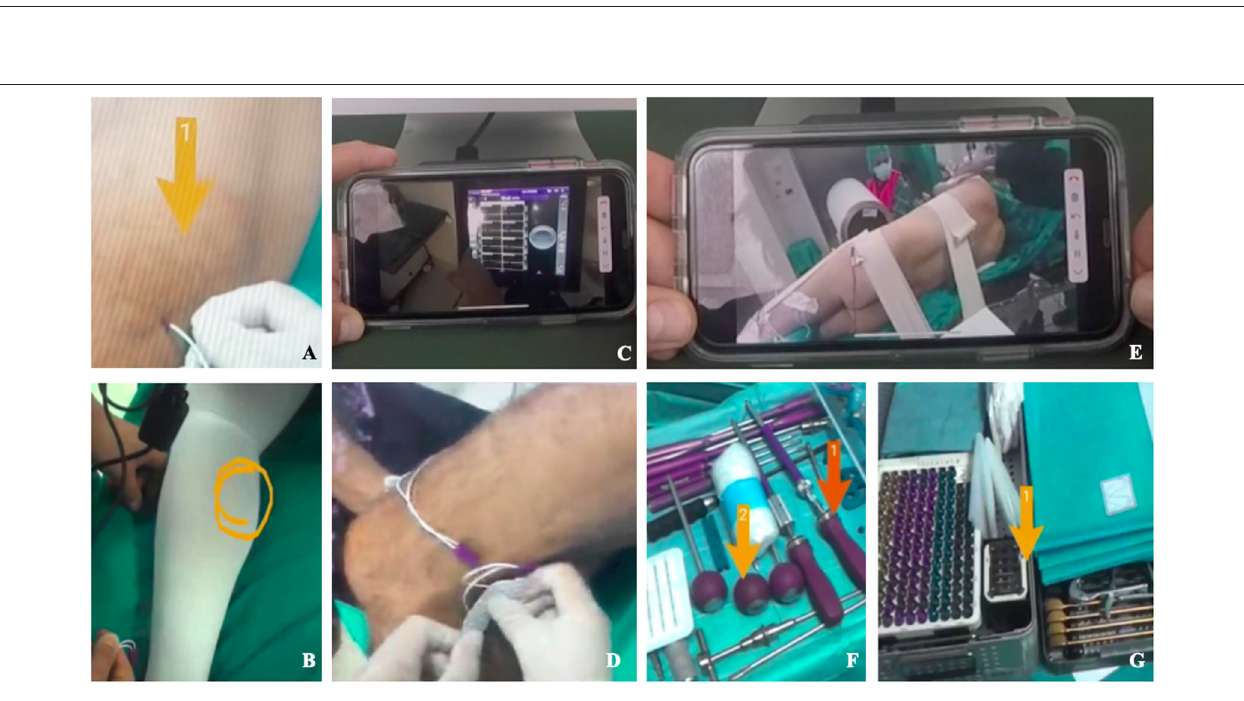
Frontiers in Surgery | www.frontiersin.org